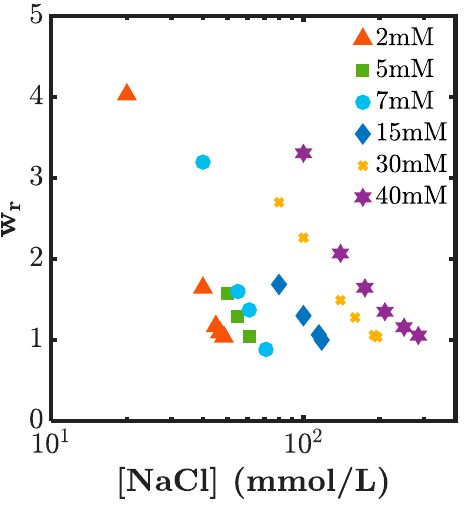
Figure 6. Swelling ratio W r of the dual-crosslink hydrogel for different initial concentrations in NiCl 2 , versus the NaCl concentration in the solution.